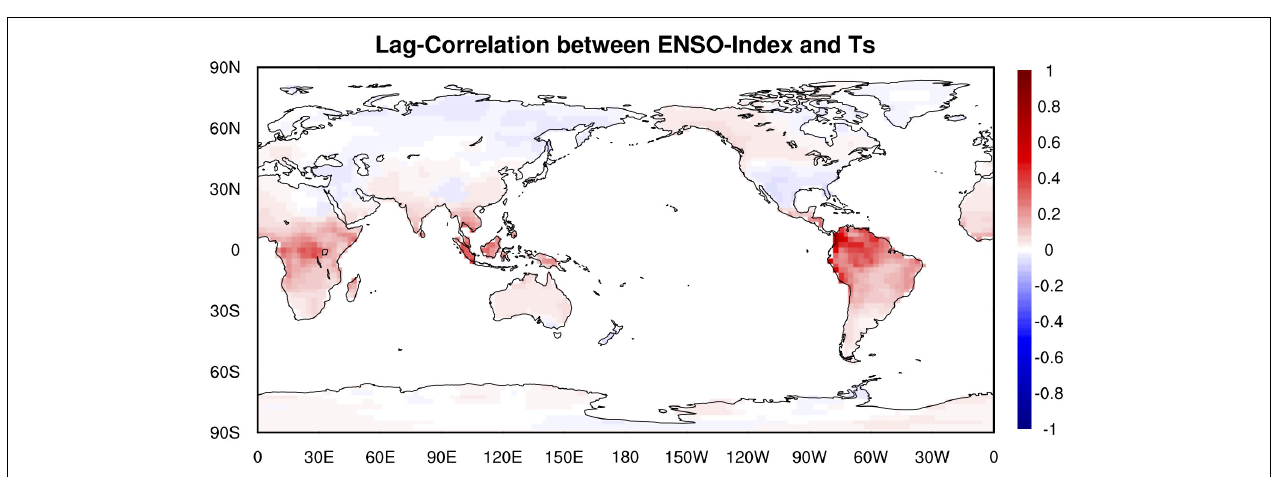
FIGURE 3 | (A) Regions where surface air temperature is Granger caused by ENSO index (red shaded). (B) Regions where surface air temperature causes ENSO (red shaded).